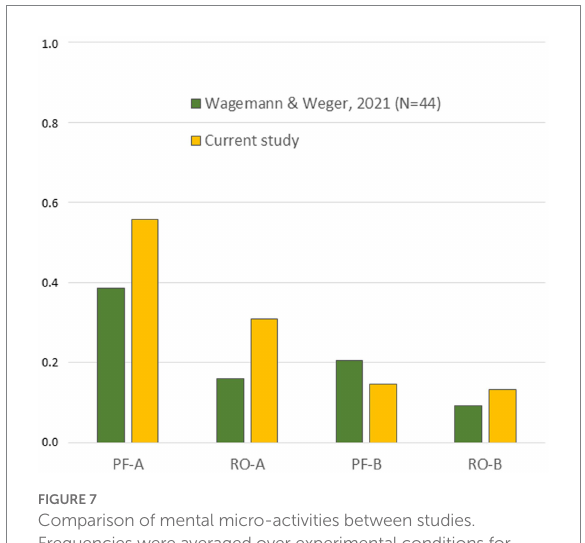
FIGURE 7 Comparison of mental micro-activities between studies. Frequencies were averaged over experimental conditions for both studies. All differences were not significant, p >